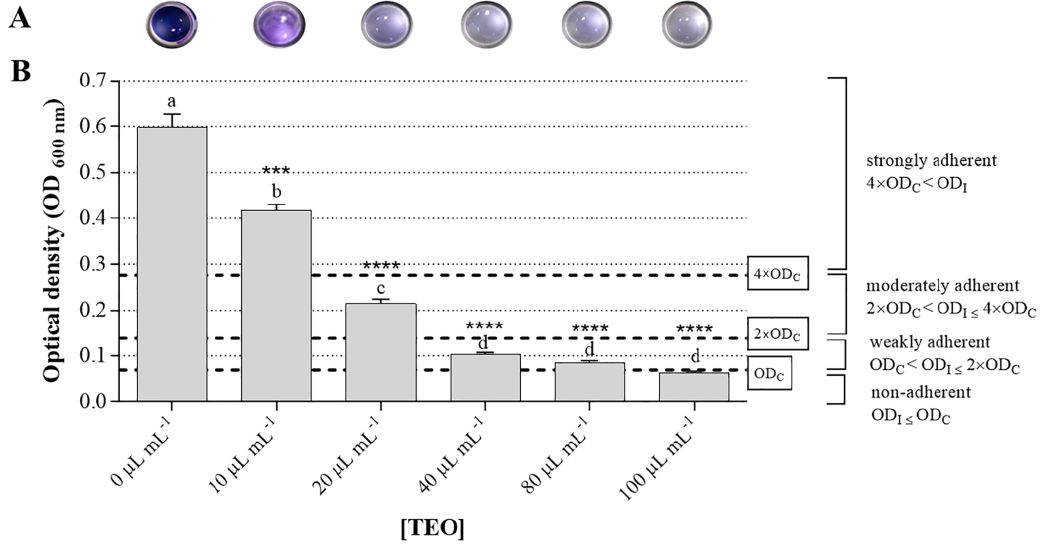
Figure 3. Adherence levels of S. Typhimurium ST1 food isolate. ( A ) Biofilm biomass at the bottom of multi-well plates in the presence and absence of increasing concentrations (10, 20, 40, 80, 100 µL mL − 1 ) of TEO. ( B ) Optical density (OD) values, detected by absorbance reading at a wavelength of 600 nm with a microplate reader, of bacterial biofilms developed by S. Typhimurium ST1 in absence and in the presence of increasing concentrations (10, 20, 40, 80, 100 µL mL − 1 ) of TEO. The comparison with negative control, represented by the broth medium, allowed to determine the level of adherence for each experimental condition. One-way ANOVA test was performed to evaluate statistical significance. Bars comparison with positive control bar (absence of TEO) was analyzed by Dunnett’s post hoc test ( p < 0.05), using asterisks to indicate statistical significance with respect to the positive control (**** p < 0.0001; *** p < 0.001). Tukey’s post hoc test ( p < 0.05) allowed to examine the statistical significance for multiple comparisons between bars. Different letters (a–d) indicate significant differences between bars; bars with no significant differences receive the same letter. TEO, thyme essential oil; OD I , isolates optical density, OD C , negative control optical density.